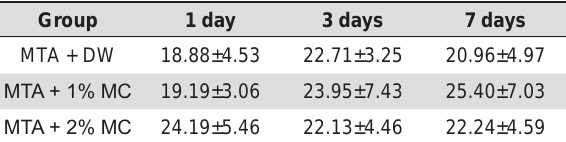
Table 1- Means and standard deviations of the compressive strengtth of test materials at various time intervals